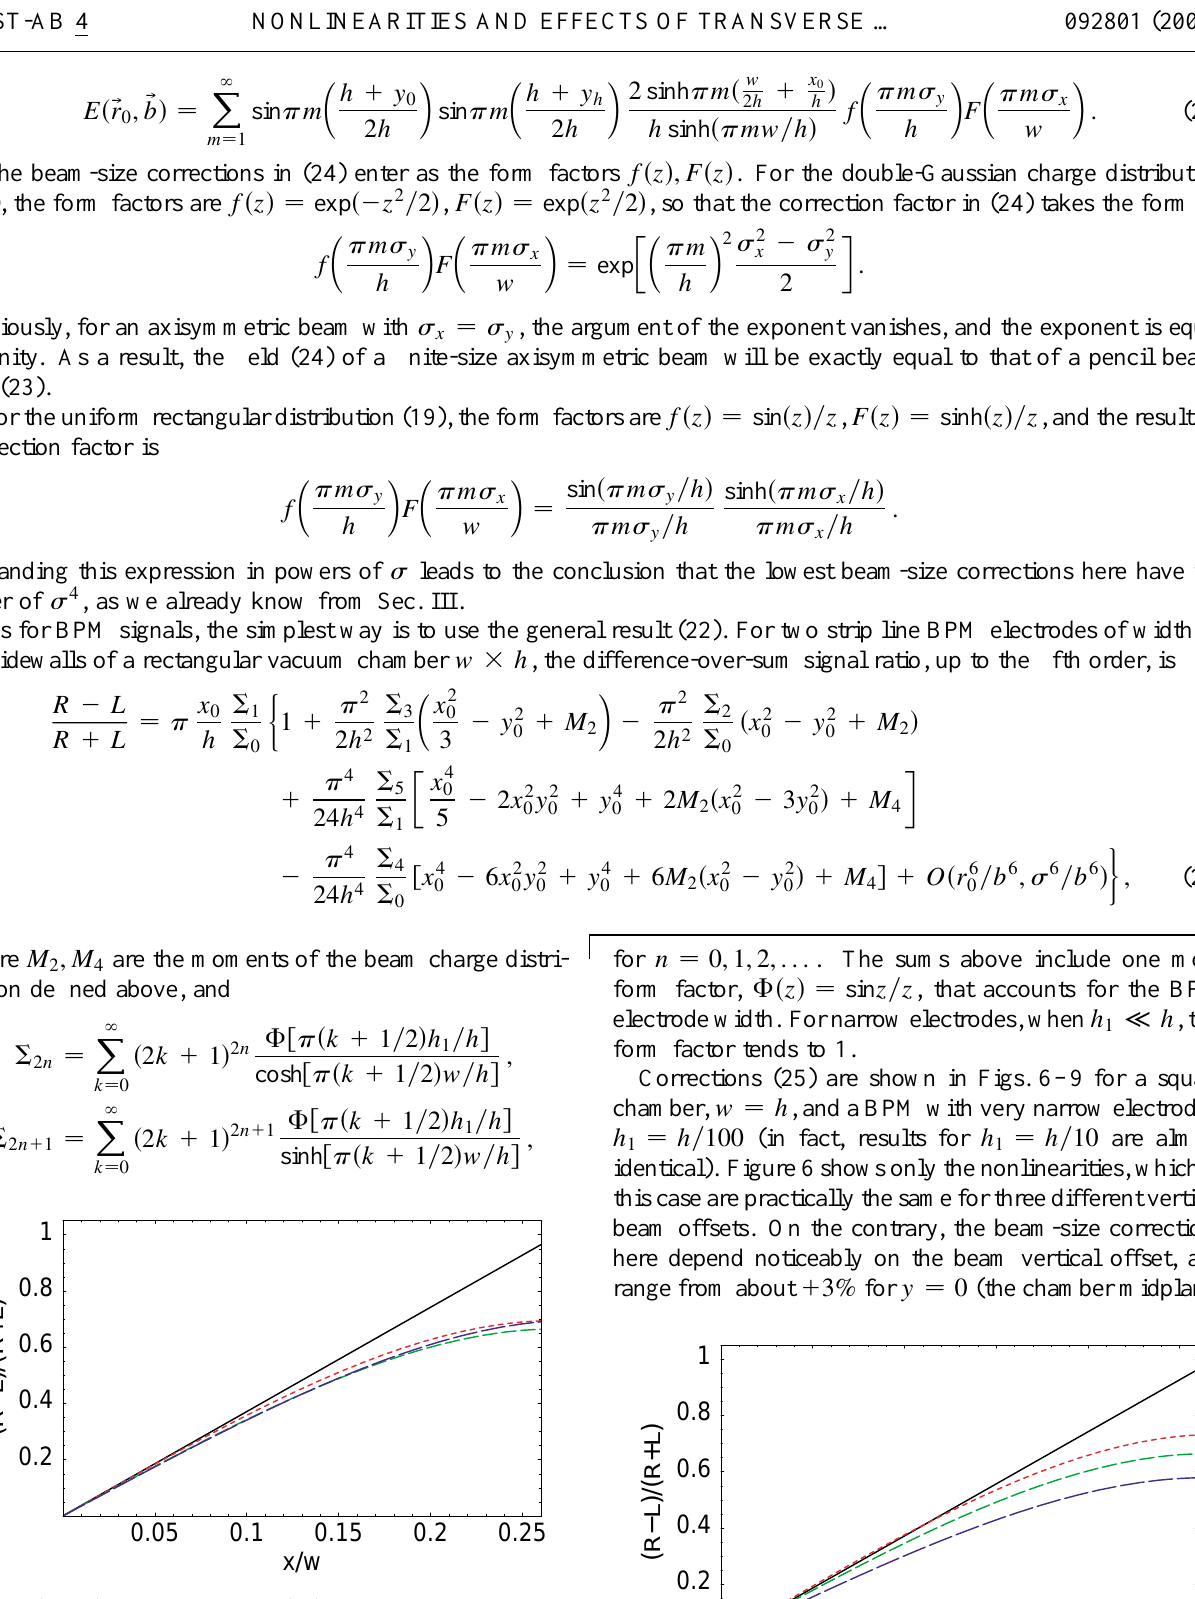
FIG. 6. (Color) BPM signal ratio (25) in a square chamber ver- sus beam center position x (cid:2) w for three vertical beam offsets y (cid:2) h (cid:1) 0, 1 (cid:2) 8, 1 (cid:2) 4 (short-dashed line, dashed line, long-dashed line, respectively) without beam-size corrections (pencil beam, s x (cid:1) s y (cid:1) 0 ). The solid line shows the linear part of the BPM response. FIG. 7. (Color) Same as Fig. 6, but with s x (cid:2) w (cid:1) 0.1 , s y (cid:1) 0